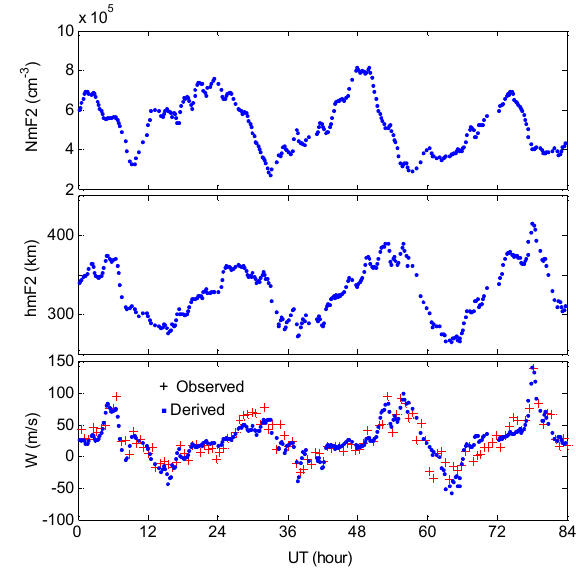
Fig. 2. Nm F2, hm F2 observed with the Millstone Hill IS radar and Fig. 2 NmF2, hmF2 observed with the Millstone Hill IS radar and a comparison of a comparison of equivalent winds observed with IS radar (‘+’) and equivalent winds observed with IS radar (‘+’) and deduced (‘•’) with our method from deduced (‘o’) with our method from observed hm F2 and Nm F2 dur- observed hmF2 and NmF2 during the days 177-180, 1990. ing the days 177–180,